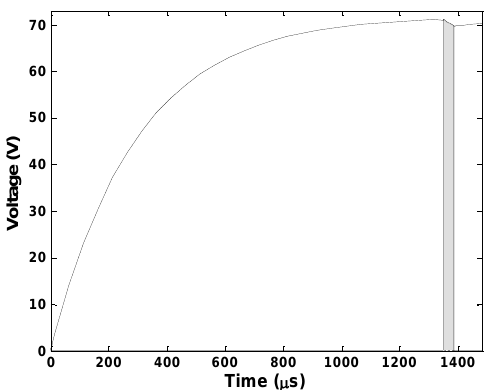
Figure 7. Decoupling capacitor charging time and change in the voltage at pulser high voltage power supply pin ( dashed-dot line ). 10 cycle output ( solid line ).